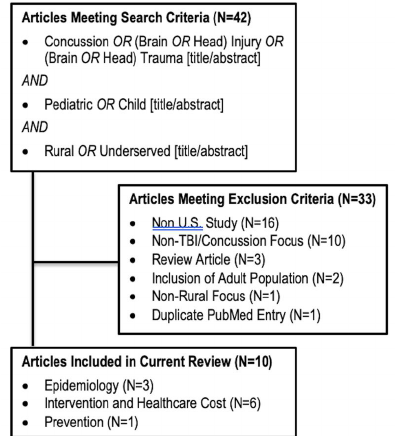
Figure 1. Flow Diagram of Included Articles.